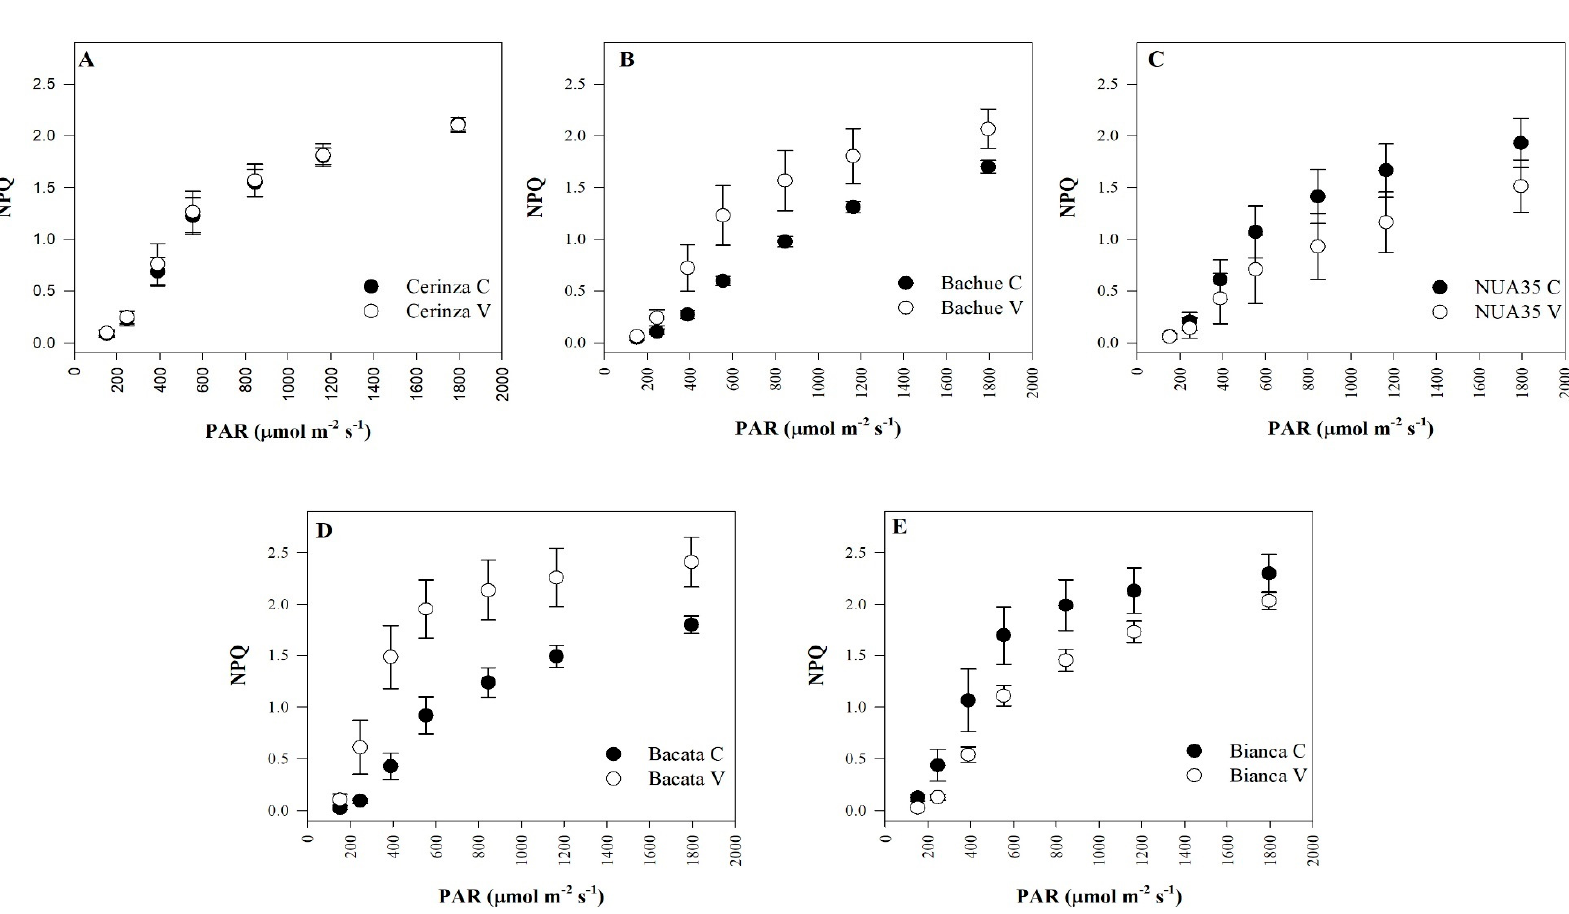
Figure 6. Non-photochemical quenching (NPQ) obtained from rapid light-response curves of ‘Cerinza’ ( A ), ‘Bachue’ ( B ), ‘NUA35’ ( C ), ‘Bacata’ ( D ) and ‘Bianca’ ( E ) under two water treatments (control ( (cid:8) ) and water-stressed ( ) plants) at the end of vegetative stage (55 DAE). Data represent the mean of four data points ± standard error